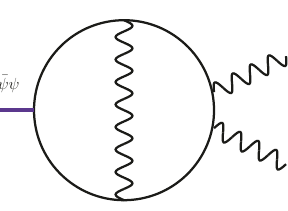
Figure 1 . A fermion loop containing (cid:22) 2 O even . The gamma trace contains 9 gamma matrices (5 from fermion propagators and 4 from quark-gluon vertices) and thus vanishes.